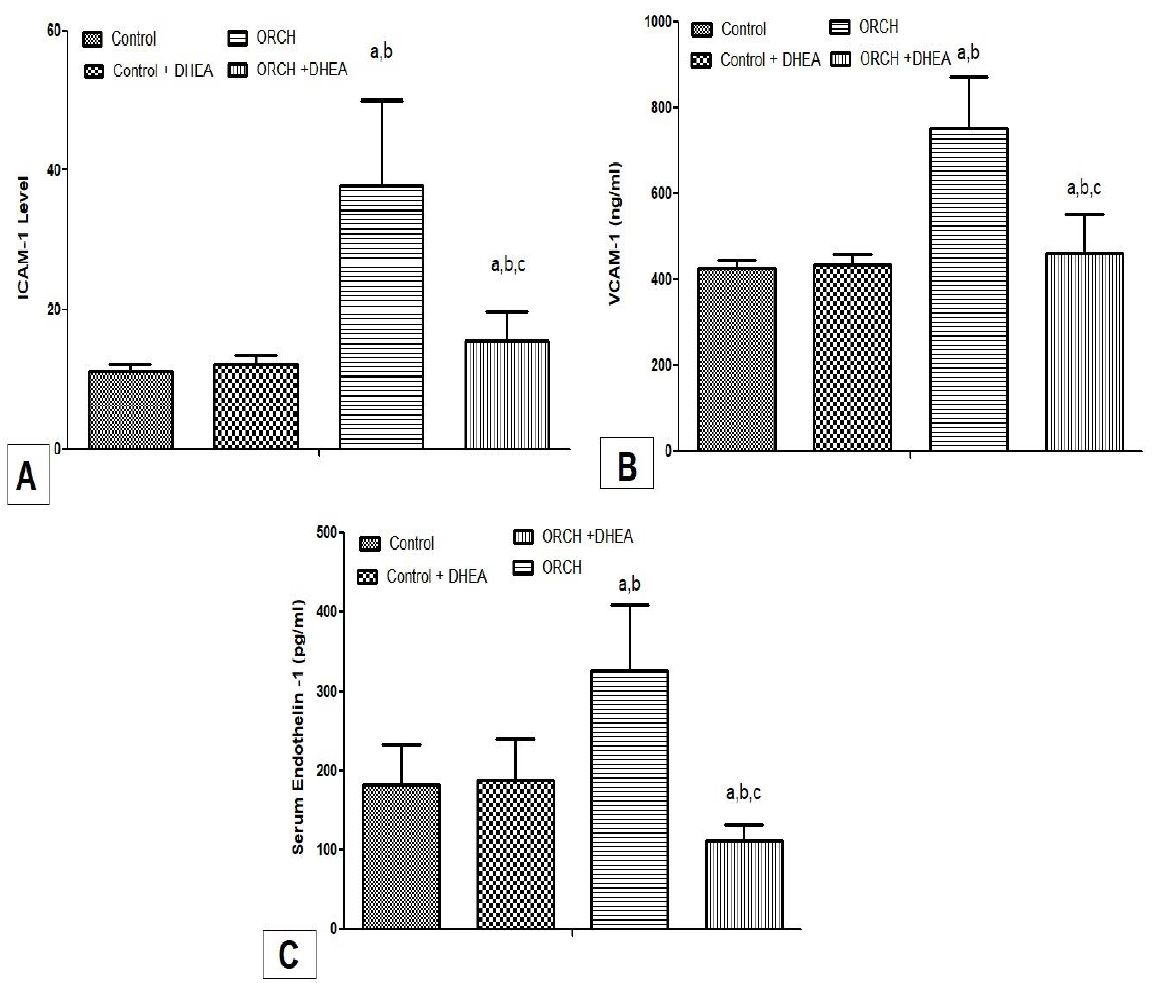
Figure 2. Effect of DHEA on ( A ) ICAM-1 (intercellular cell adhesion molecule) level, ( B ) VCAM-1 (vascular cell adhesion molecule-1) level, and ( C ) Serum endothelin-1 level in orchidectomized rats. a : significance relative to control group, b : significance relative to Con + DHEA group, c : significance relative to ORCH. ORCH = orchidectomized rats and DHEA = dehydroepiandrosterone.